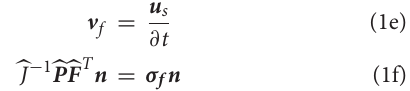
ostia). The flow rate was smoothly ramped up until a